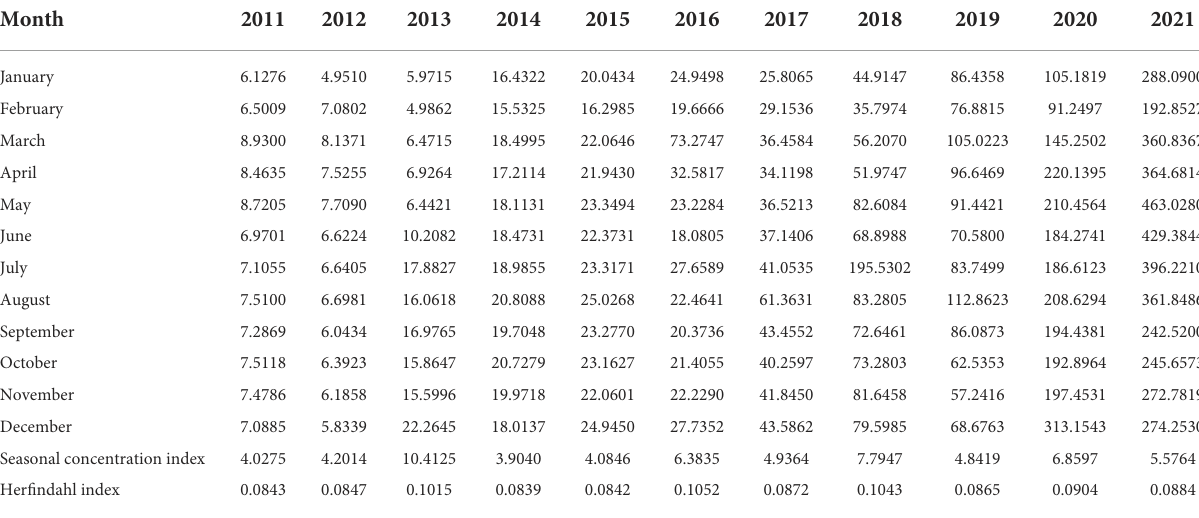
FIGURE1 Changes in OAV from 2011 to 2019 (unit: 10,000).